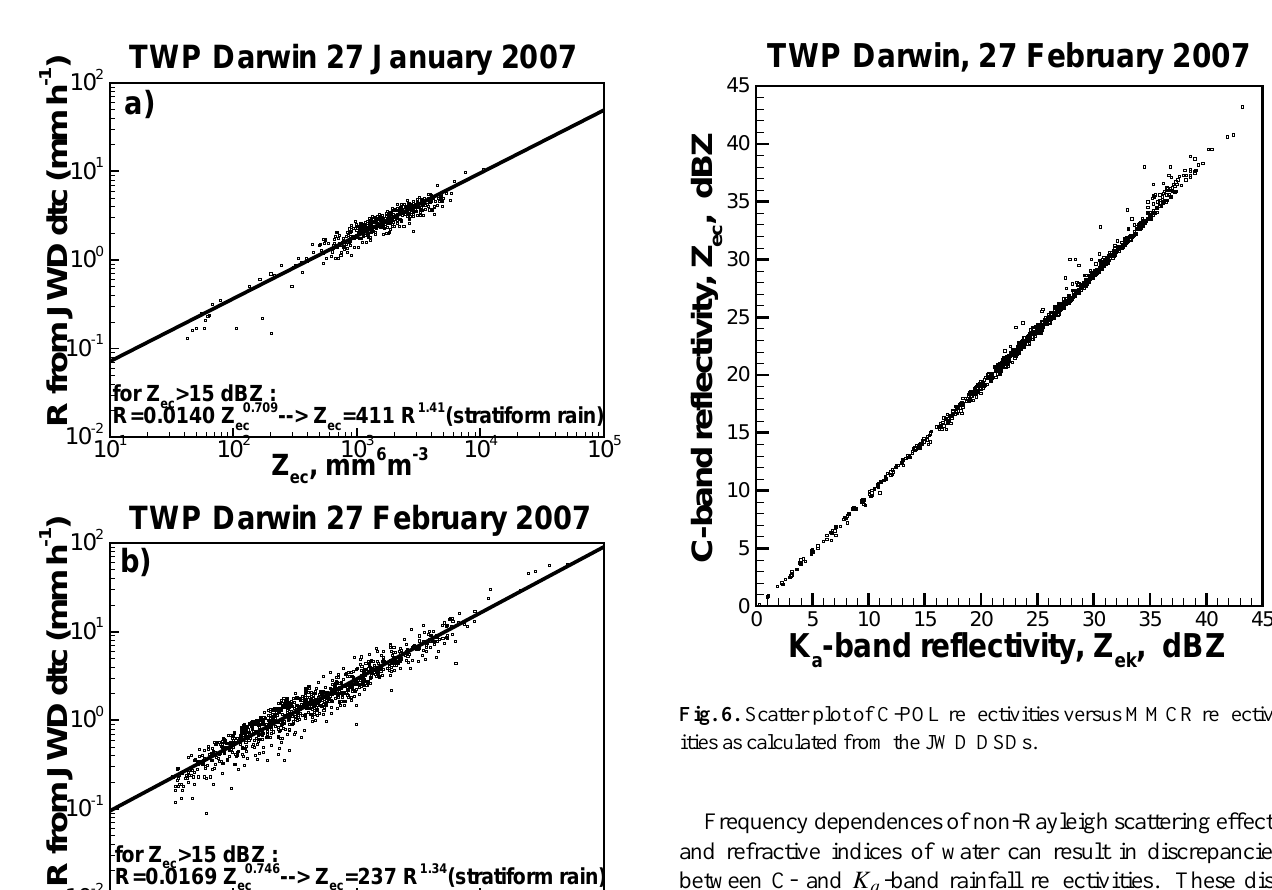
for Z >15 dBZ : ec R=0.0169 Z ec0.746 --> Z =237 R 1.34 (stratiform rain) ec Z , mm 6 m -3 ec Fig. 5. Scatter plots of C-band radar reflectivity versus rain rate as calculated from the JWD DSDs measured during the events of 27 January 2007 (a) and 27 February 2007 (b) .